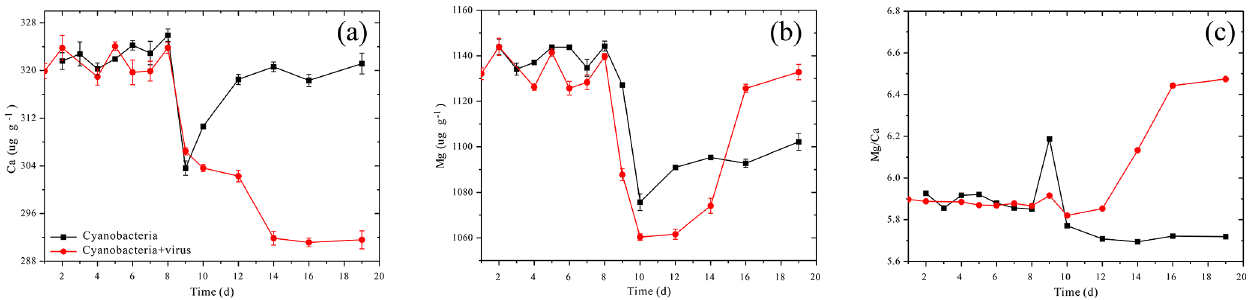
Figure 3. Changes in the solution’s calcium concentration (a) , magnesium concentration (b) , and Ma / Ca atomic ratio (c)